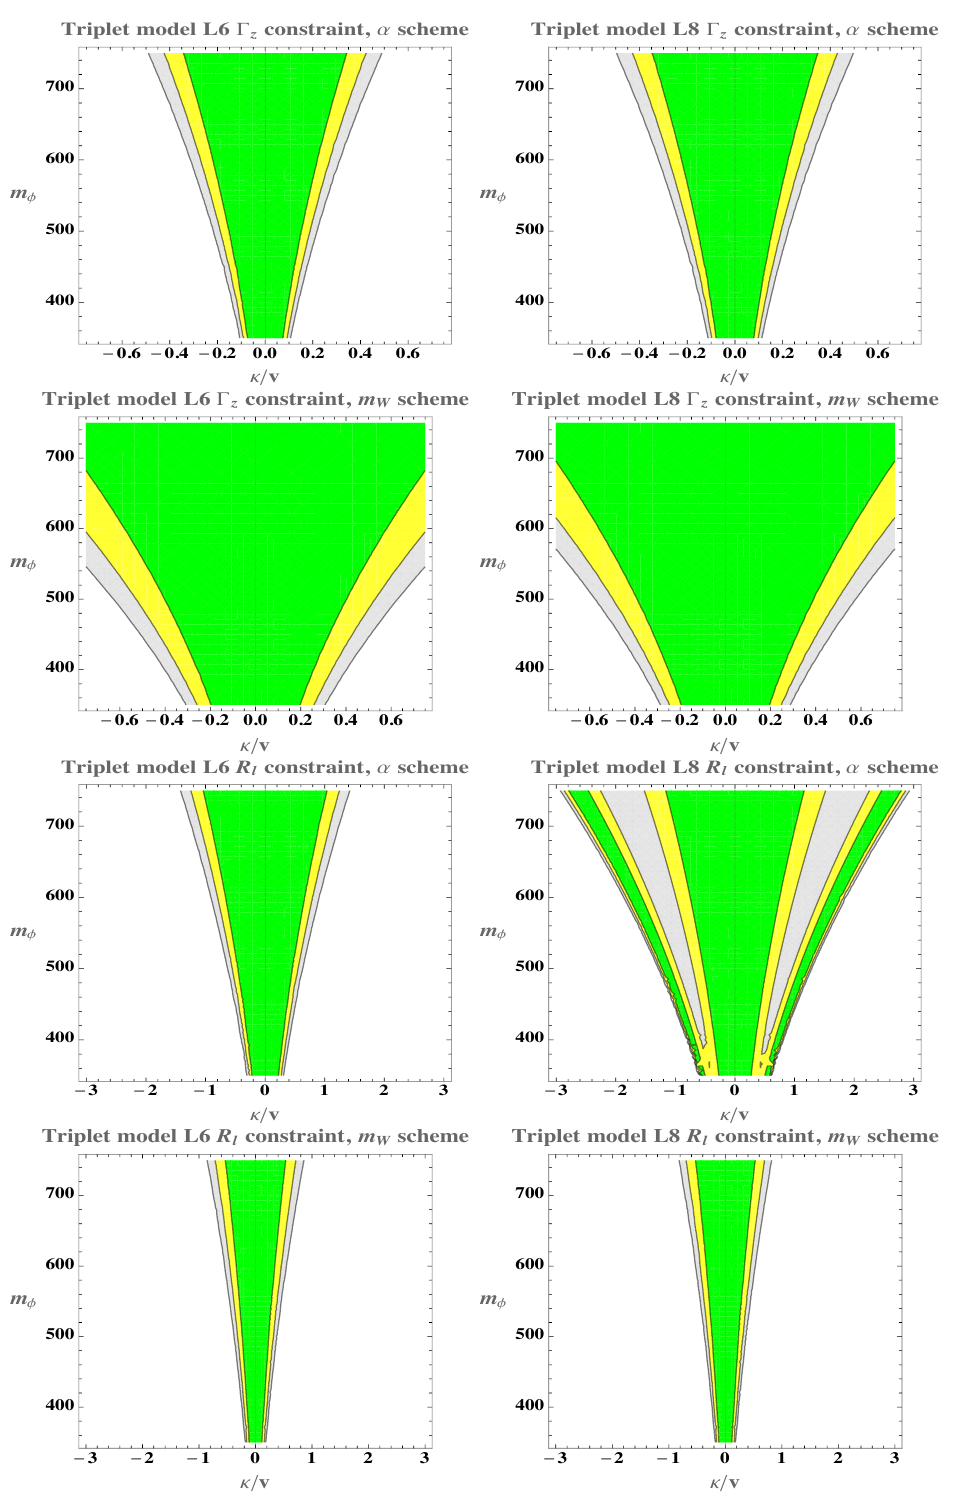
Figure 9 . Constraints from EWPD observables in the scalar triplet model. Same conventions as in previous plots. Shown are the constraints on the model space from the Γ Z and R ‘